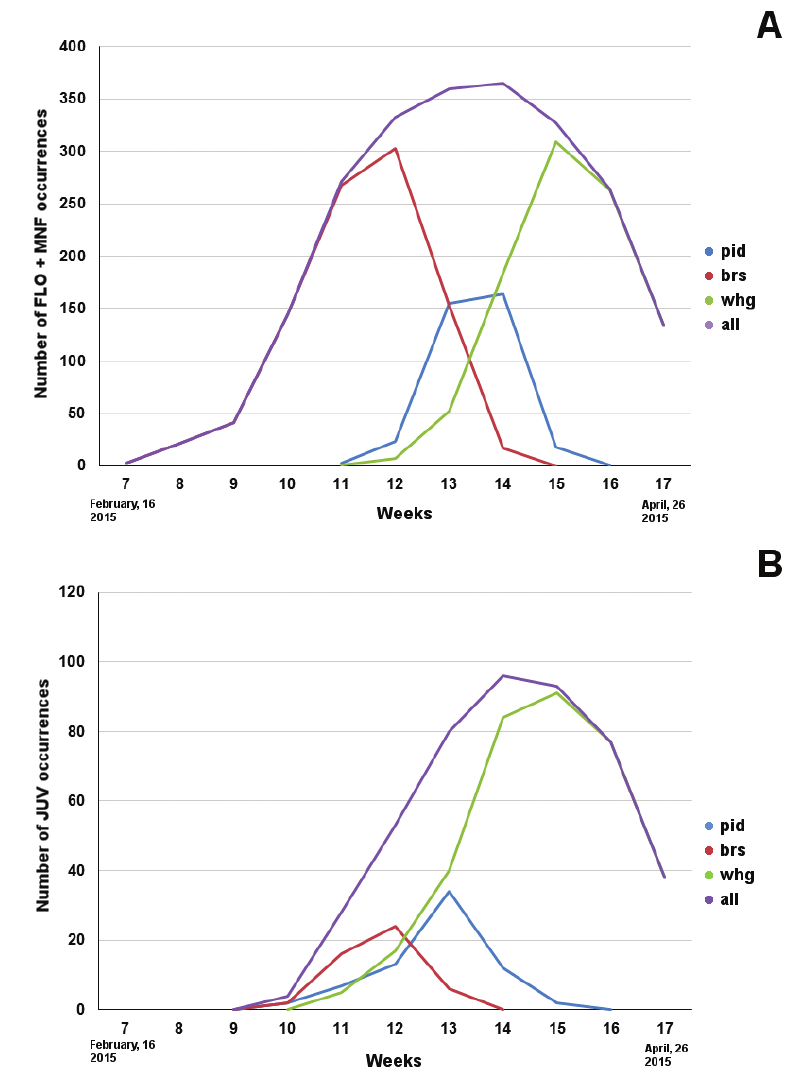
Figure 5. Discoloration: loss of red pigment from red-brown spots in E. dens-canis leaves. Time course of the discoloration in A adult plants (FLO and MNF), and B JUV